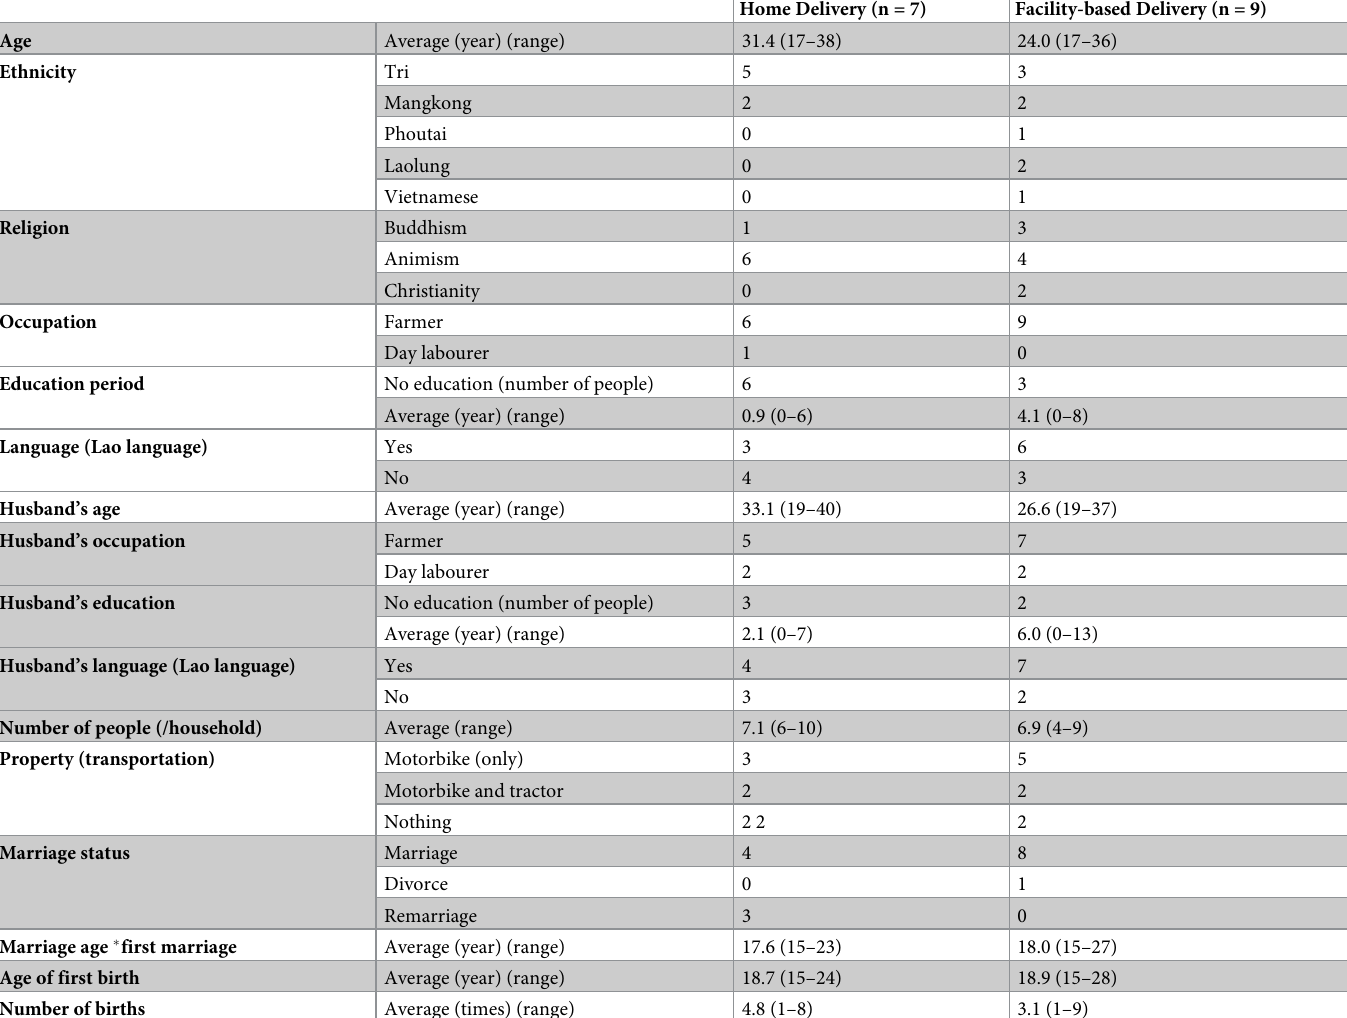
Table 1. Characteristics data of our included